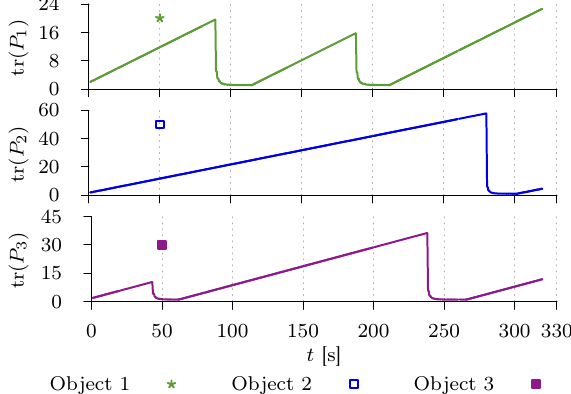
Figure 11: The trace of each object’s covariance ma- trix. An object observation is indicated by a significant reduction in the trace